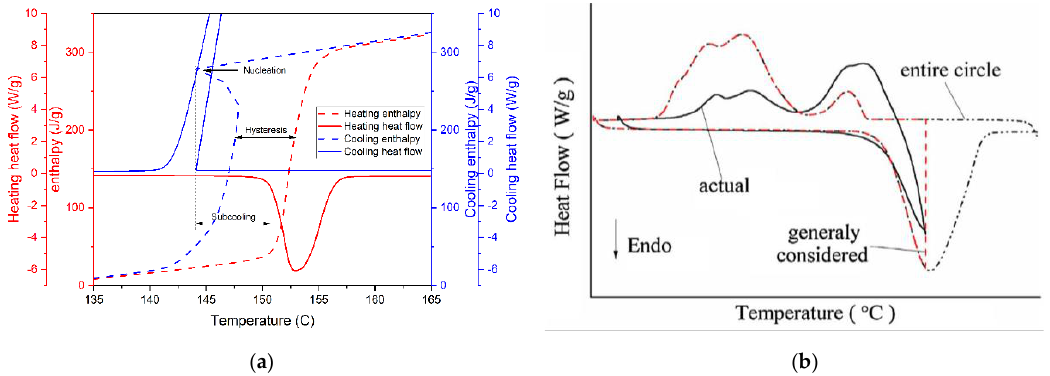
Figure 6. PCMs heat flow curves: ( a ) subcooling hysteresis (personal data); ( b ) partially melted PCM (micro encapsulated paraffin wax), after [46]. Table 5. Challenges in calorimetry measurements of PCMs.